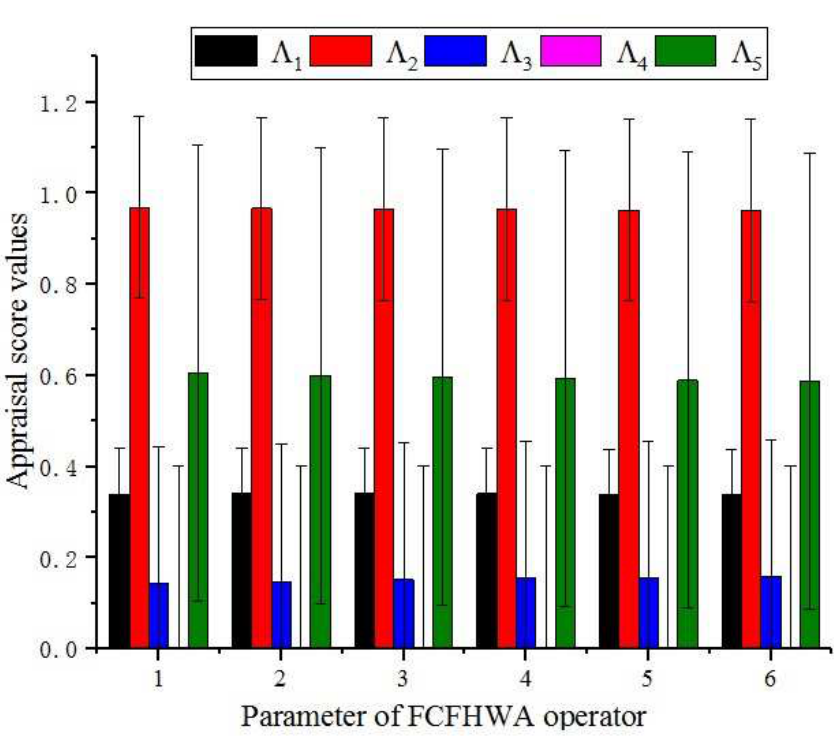
Figure 2. Decision results regarding different parameter ℵ for the FCFHWA operator.